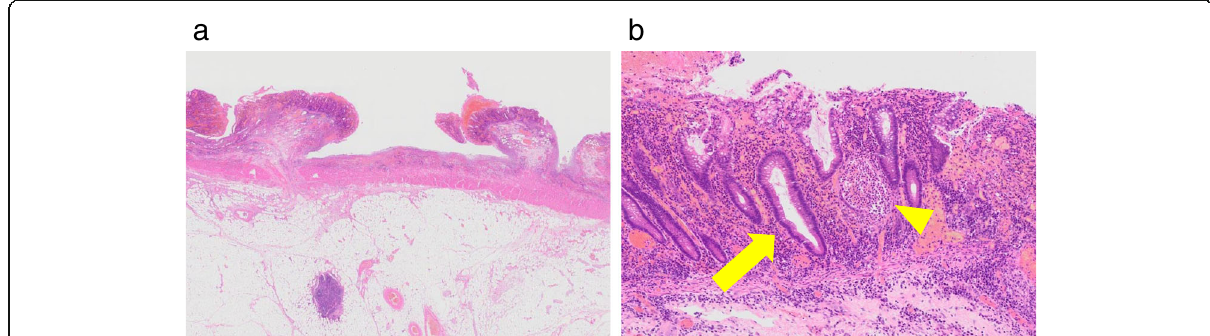
Fig. 7 a Macroscopic appearance of the resected specimens showing pseudopolyps. HE staining (× 6). b Microscopic findings showing goblet cell depletion (arrow), crypt abscesses (arrowhead), and infiltration of polymorphonuclear cells. HE staining (×